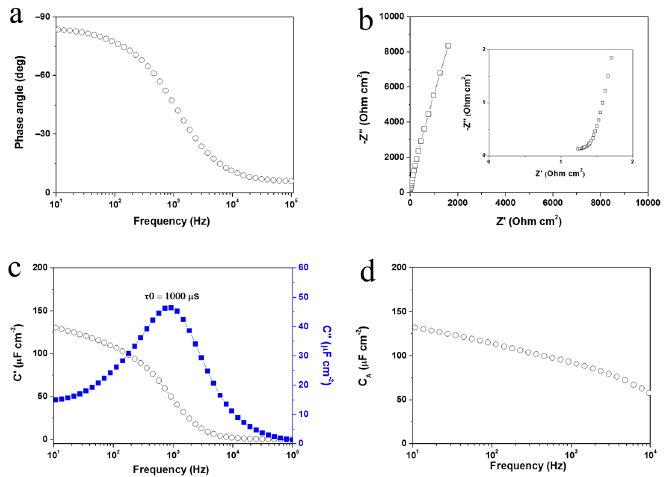
Figure 4. Full cell measurement of off-chip HFSCs with Ti foils as the substrates: ( a ) Phase angle versus frequency, ( b ) Nyquist plot, ( c ) Plots of the real or imaginary part of the specific capacitance as a function of frequency, ( d ) Areal specific capacitance versus frequency.